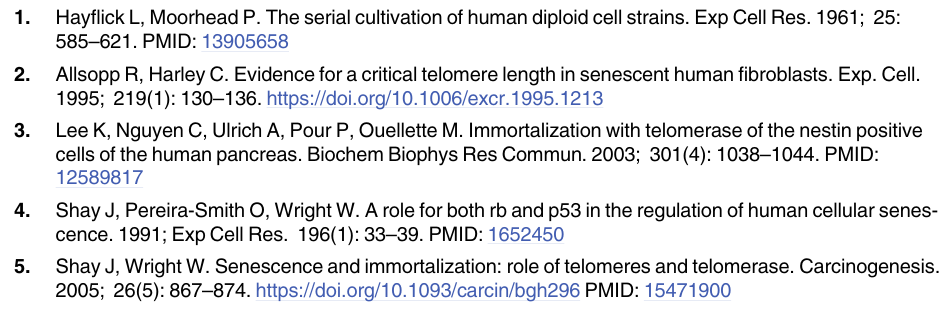
S1 Fig. Karyotype of sub-clonal immortalized line K#1.1. Total of 30 recorded images were used to determine the karyotype number of the sub-clonal line K#1.1 as 46, XY. (TIFF) S2 Fig. Panther gene ontology analysis. Genes upregulated in monoclonal immortalized line K#1 are predominantly related to cellular communication and primary metabolic processes (biological process), and catalytic activity, binding and receptor activity (molecular function).